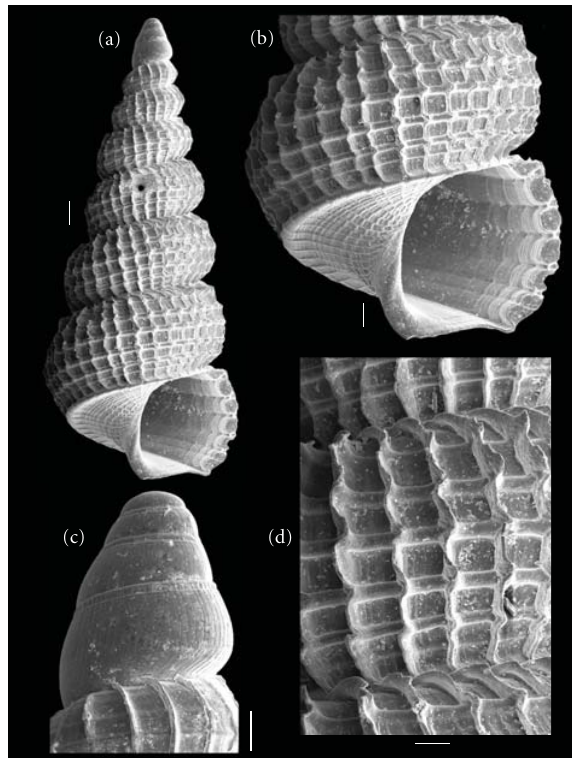
Figure 5: (a–d) Amaea retifera (LMUFRPE); (a) ventral view, (b) view of last whorl, (c) protoconch, and (d) detail of teleoconch ornamentation. Scale bars: (a), (b) and (d) 500 μ m, (c) 100 μ